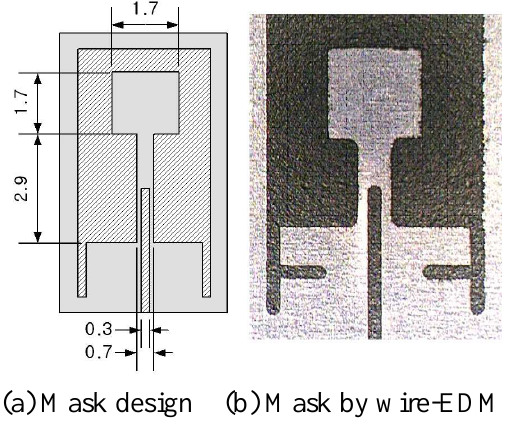
Figure 7 . Design and shape of the metal